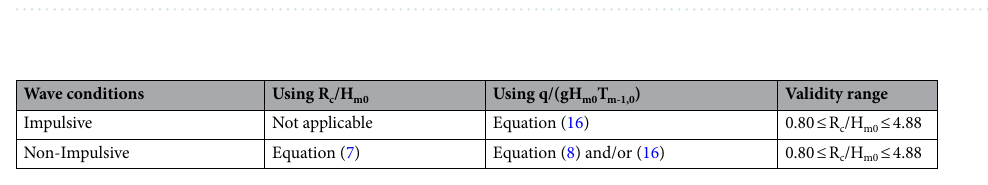
Table 4. Guidance for the estimation of Weibull b values at vertical